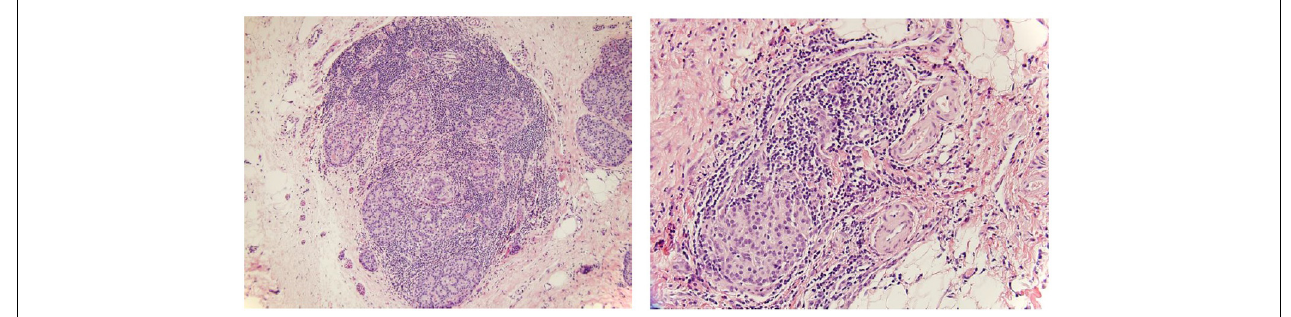
FIGURE 1 | Example of the insulitis characteristic of type 1 diabetes in a patient with chronic pancreatitis. Lymphocytic inflammation surrounds and infiltrates the islet tissue while the exocrine tissue is largely fibrotic from CP.